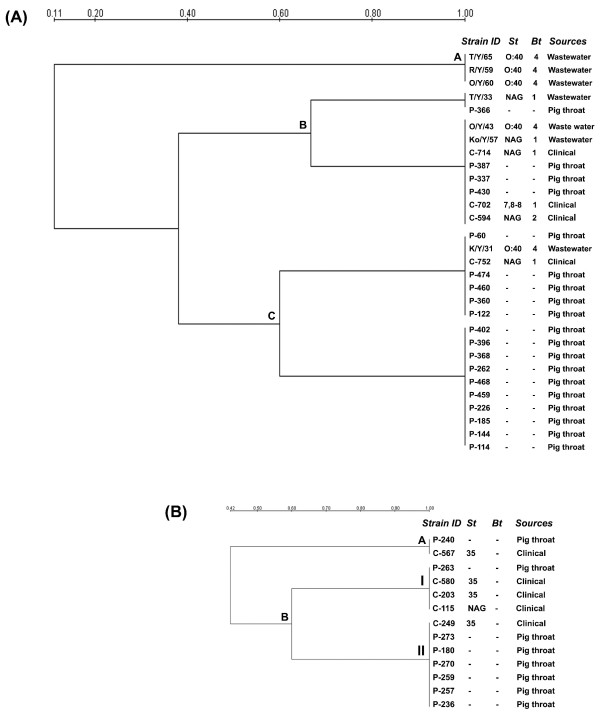
Phylogenetic analysis of blaA gene of (A)Y. intermedia and (B) Y. frederiksenii. NAG, non-agglutinable; -, Not determined; St, Serotype; Bt, Biotype